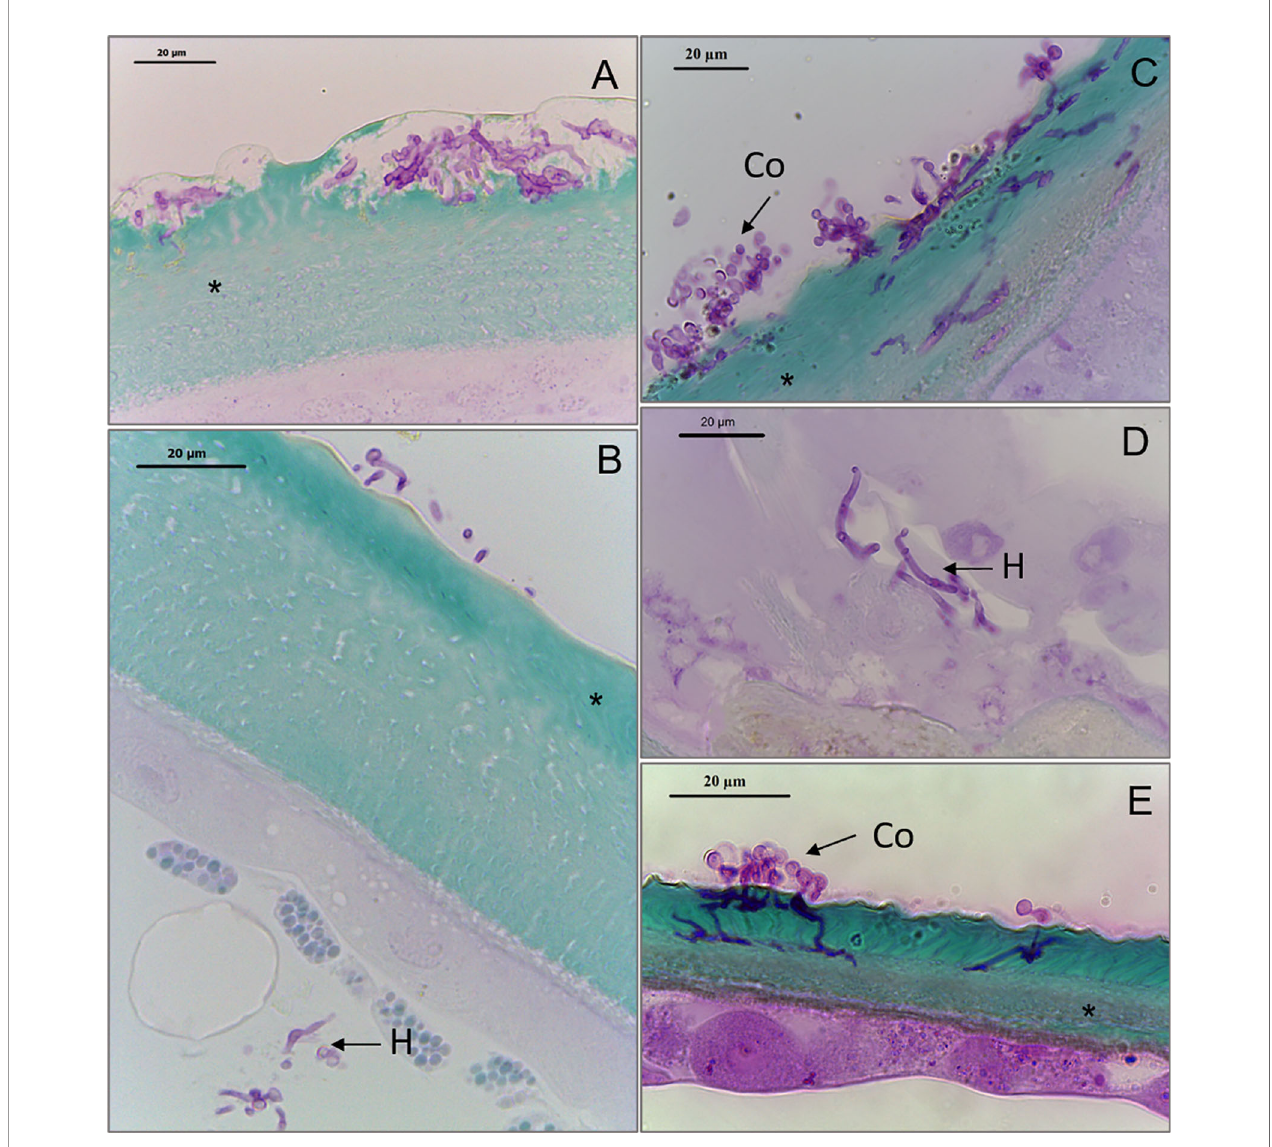
FIGURE 4 | Sagittal sections of Rhipicephalus microplus engorged females treated with conidia of Beauveria bassiana strains: BbWT , D Bbmsn2/Bbmsn2 or D Bbmsn2 , and incubated for 120 h at 26 ± 1°C and RH ≥ 90%. Germinating conidia of BbWT penetrates through the tick cuticle (A) Germinating conidia of BbWT attaches to the tick cuticle and fungal hyphae infecting the tick interior (B) Germinating conidia of D Bbmsn2/Bbmsn2 penetrates through all the layers of the tick cuticle (C) Hyphae of D Bbmsn2/Bbmsn2 infects the interior tick tissues (D) Incomplete penetration of D Bbmsn2 hyphae through the tick cuticle (E) . Co, germinated conidia; H, hyphae inside tick tissue; asterisk (*)